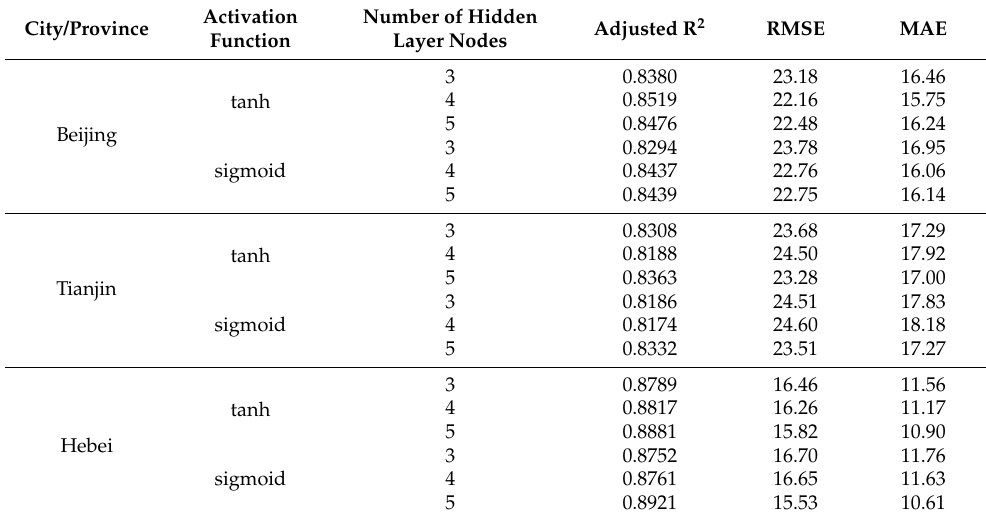
Table 6. Performance of the ANN on O 3 concentration simulation with different network structures.